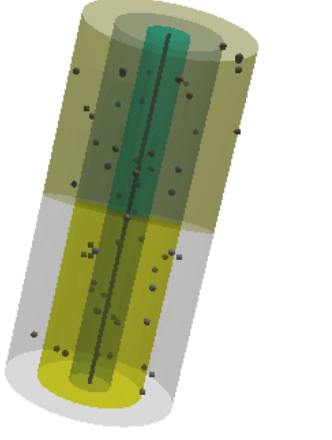
Figure 2. Cylindrical 3D Shape Context around a segment.